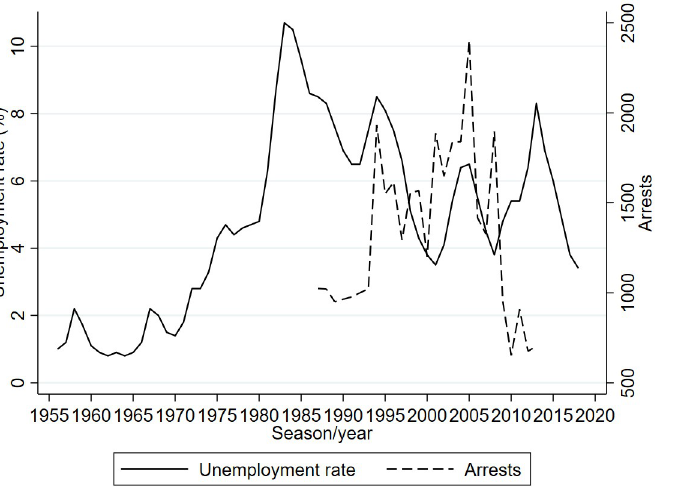
Fig 3. Unemployment rate (%) and arrests;